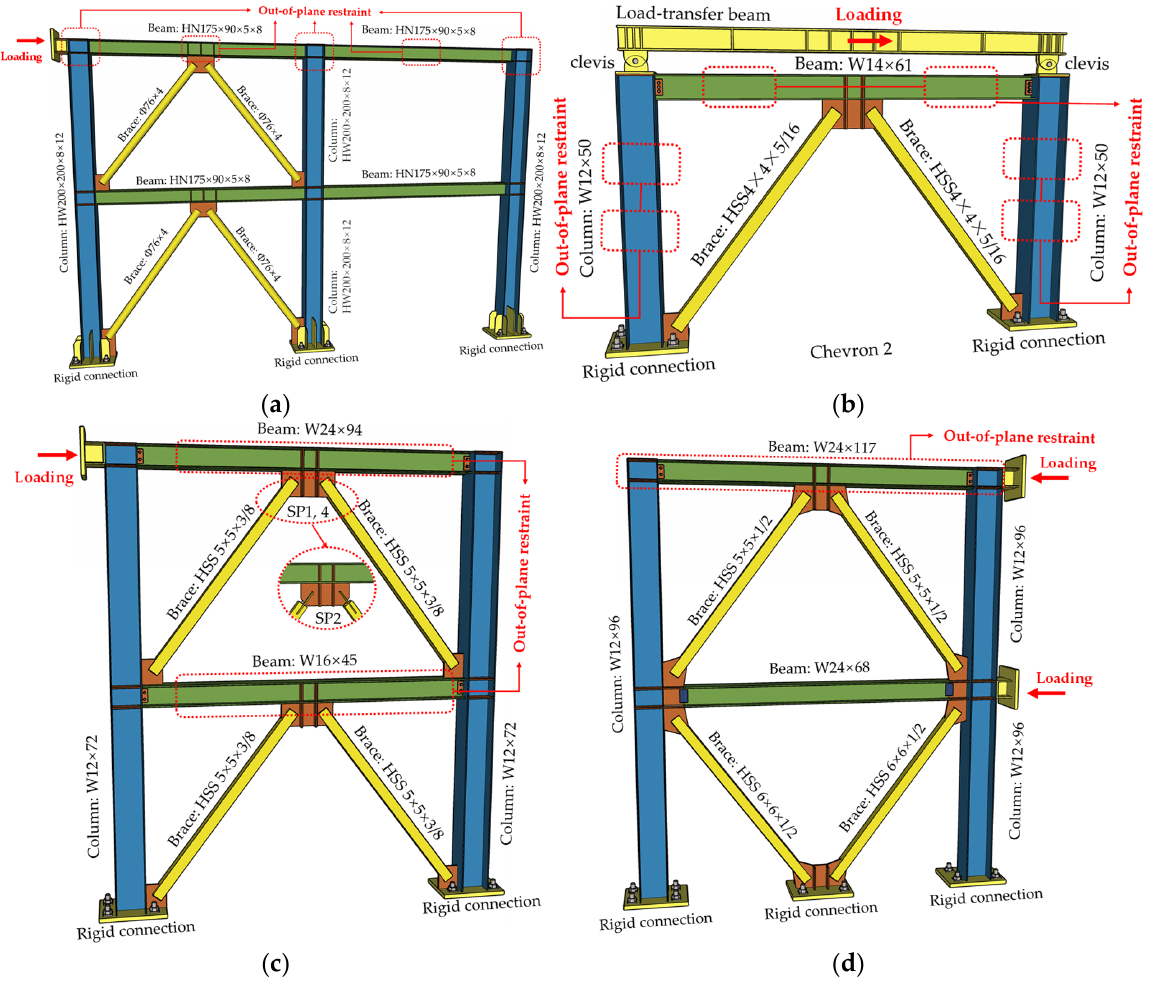
Figure 4. Published test specimens and set up. ( a ) SCBF [21]; ( b ) Chevron [23]; ( c ) SP [10]; ( d ) TCBF ‐ B ‐ 2 [22].